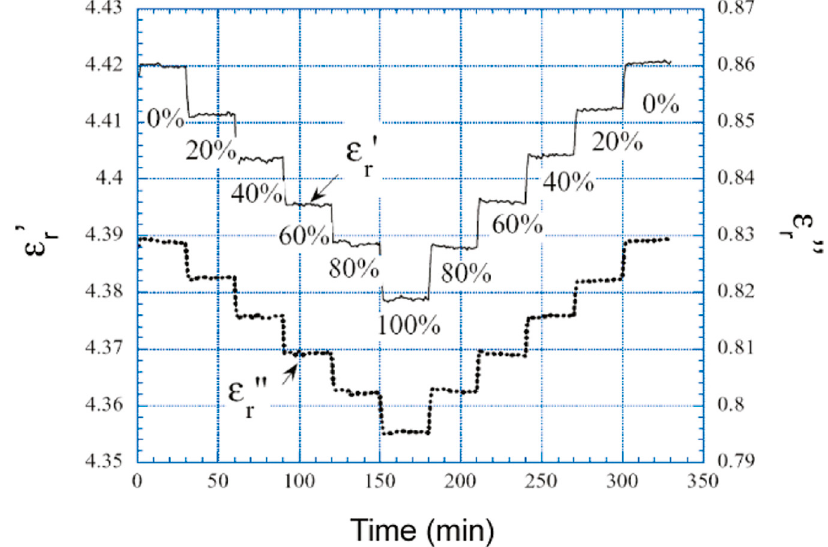
Figure 15. Carbon dioxide sensor using a wireless transducer constructed with multiwalled carbon nanotube (MWCNT)-SiO 2 film. Reproduced with permission from Reference [10].